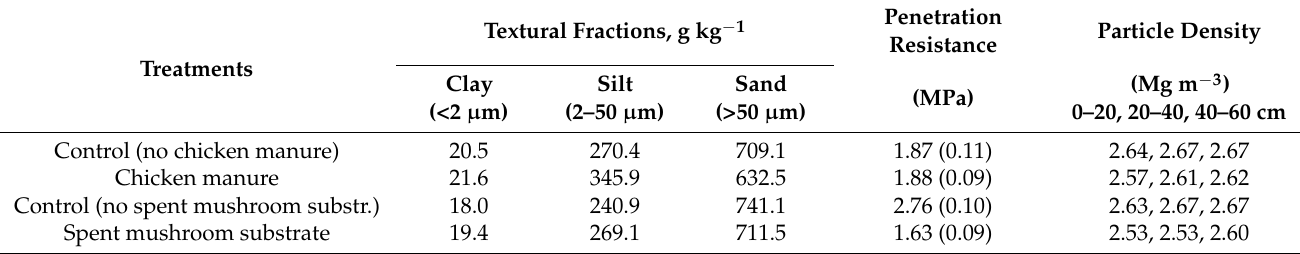
Penetration Particle Resistance